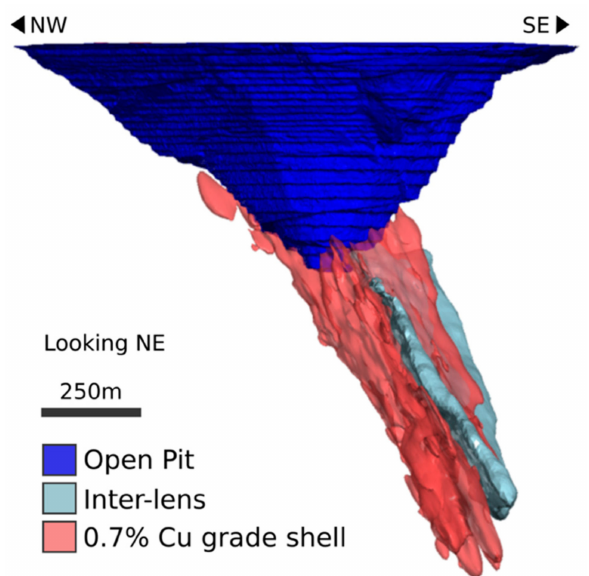
Figure 4. A 3D model depicting the extent of the Inter-lens. The Inter-lens is represented in grey, the 0.7% Cu grade shell is shown in red, and the open pit is shown in blue. Modelling shows a structure running parallel to mineralization, and trending in a moderately south to southeast direction. (Image courtesy of Chloe Hawtin, Ernest Henry